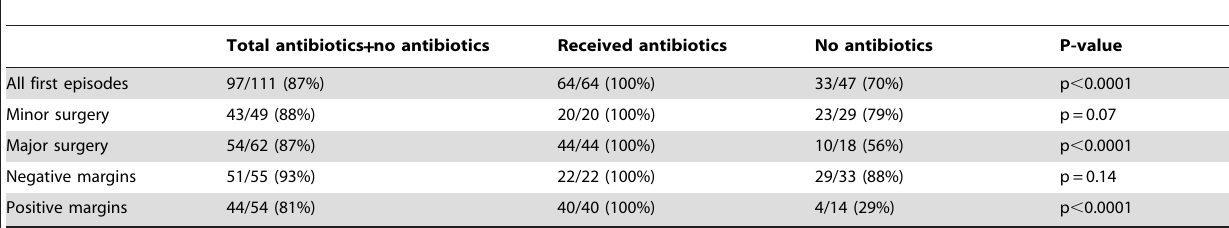
Table 3. Proportion of cases with treatment success for initial M. ulcerans lesions using fluoroquinolone-containing regimens.